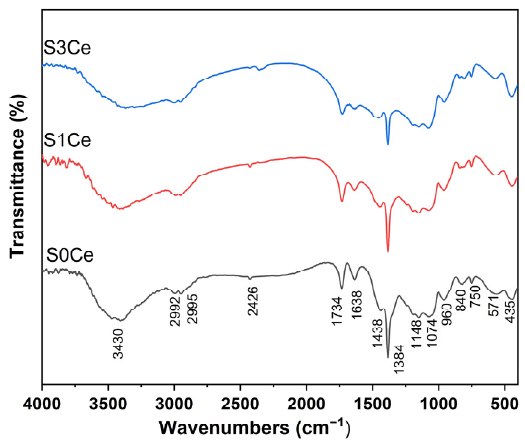
Figure 1. FTIR spectra of S0Ce-S3Ce composite scaffolds.